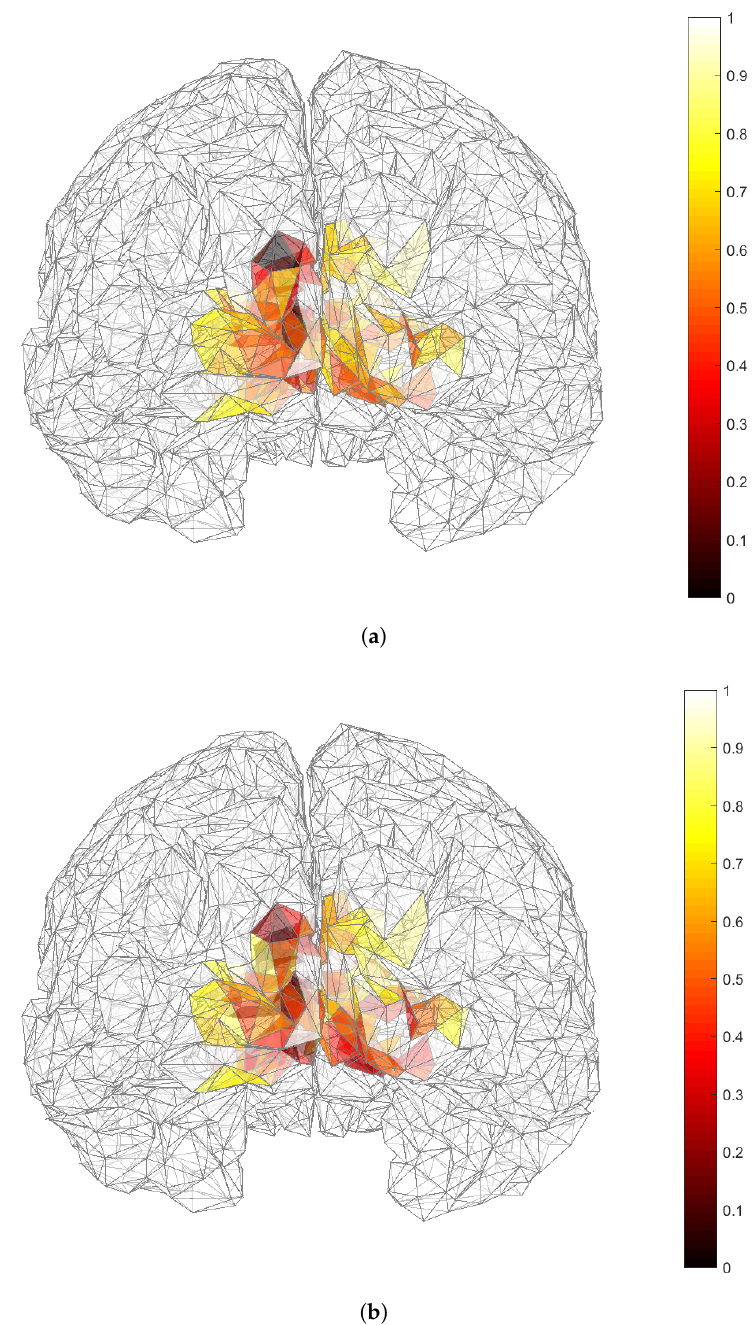
Figure 9. Results of the source localization process through our reduced-rank beamforming approach in EEG SSVEP data of Subject 10 in [27] and for a specific frequency. Minimum values of ι in darker colors) correspond to zones of main brain activation. ( a ) ι